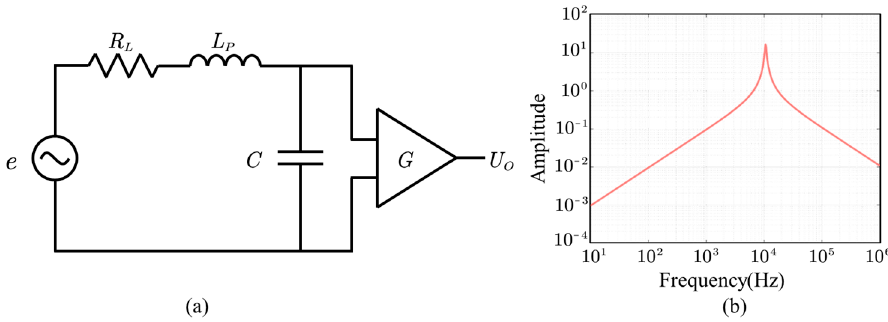
Figure 2. Equivalent circuit of the search coil ( a ) and its frequency response ( b ).